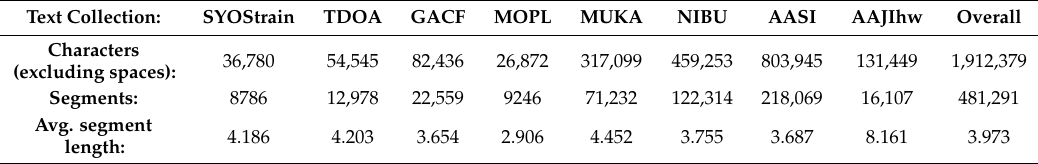
Table 1. Statistics of Ainu text collections and dictionaries used as the training